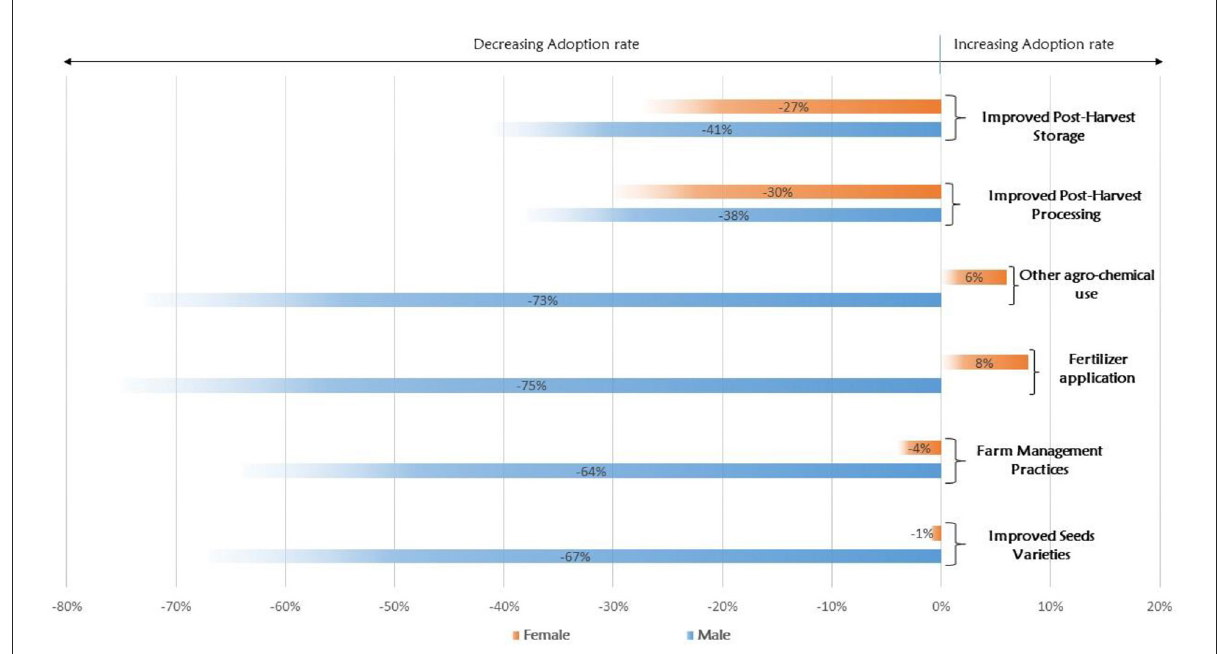
FIGURE7 Variance analysis of technology adoption rate per gender. Author, 2021.